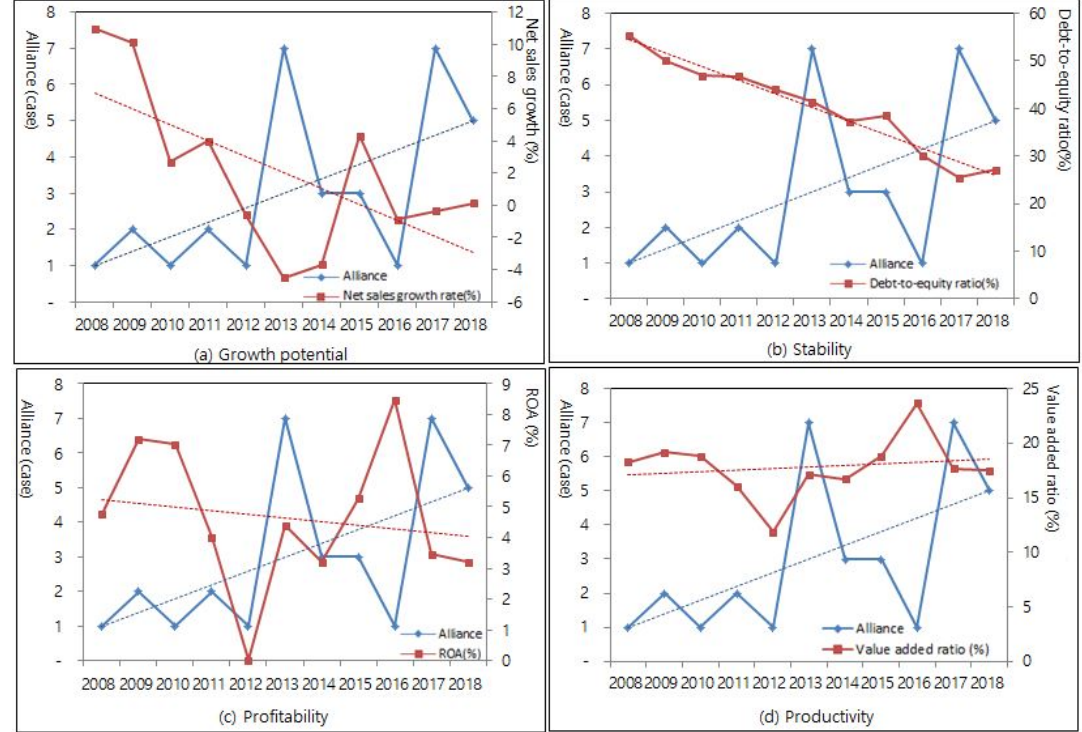
Figure 4. Analysis of Nongshim’s financial ratio.